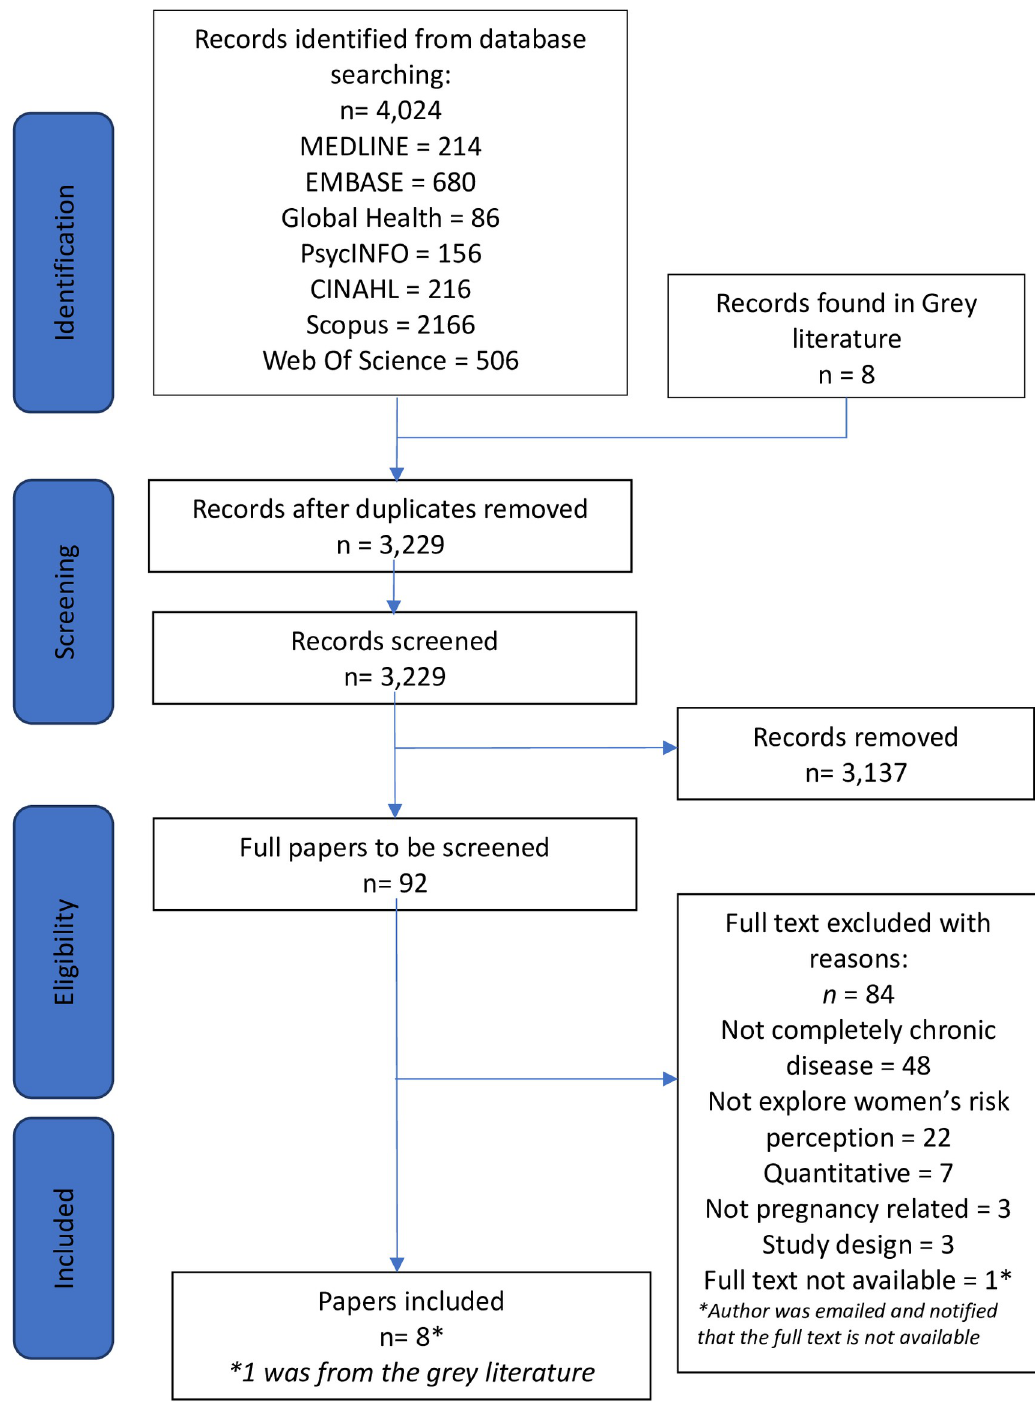
Fig 1. PRISMA diagram showing identification and selection of studies. Risk to baby. There were concerns regarding the impact of chronic disease on the baby. Concerns included fetal macrosomia for women with diabetes [30, 31] and congenital malfor- mations for women with prescribed medication for epilepsy. Women with systemic lupus